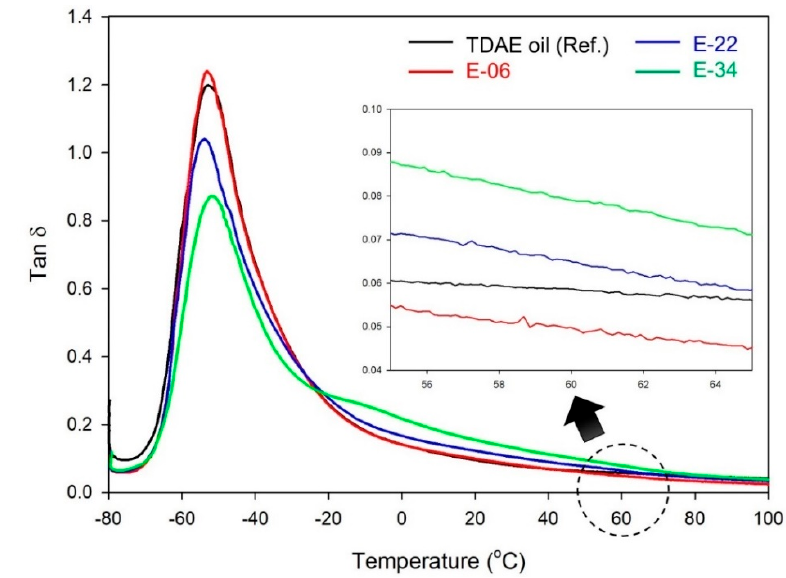
Figure 8. Temperature dependence of tan δ for the vulcanizates. Table 8. Viscoelastic properties of the vulcanizates. Table 8. Viscoelastic properties of the